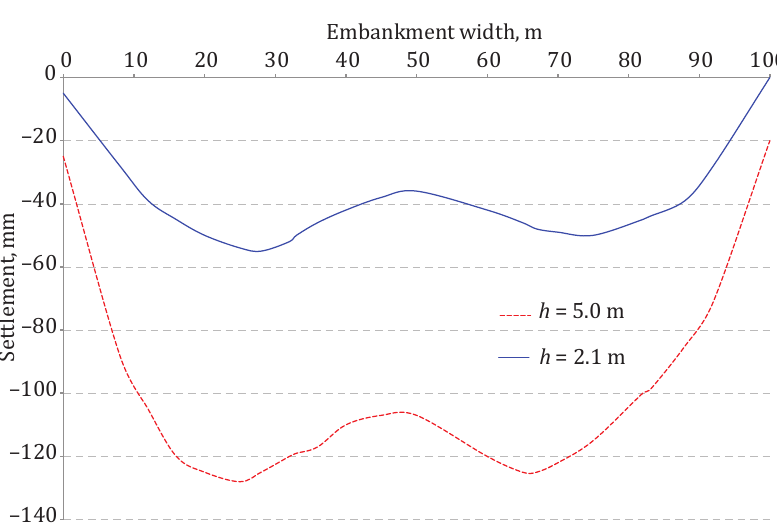
Figure 12. In-situ settlement monitoring results of K60 + 430 section (2007) of Xinxiang‒Zhengzhou No. 9 section of Beijing‒Zhuhai Expressway (mixing pile for ground